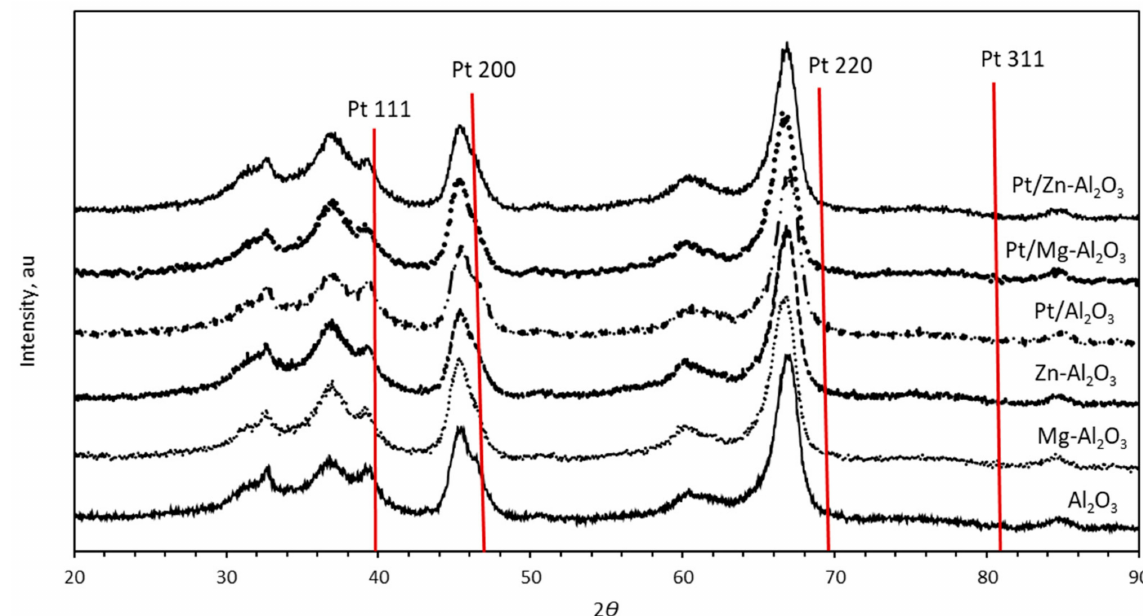
Figure 11. X-ray diffraction (XRD) patterns of catalysts and alumina